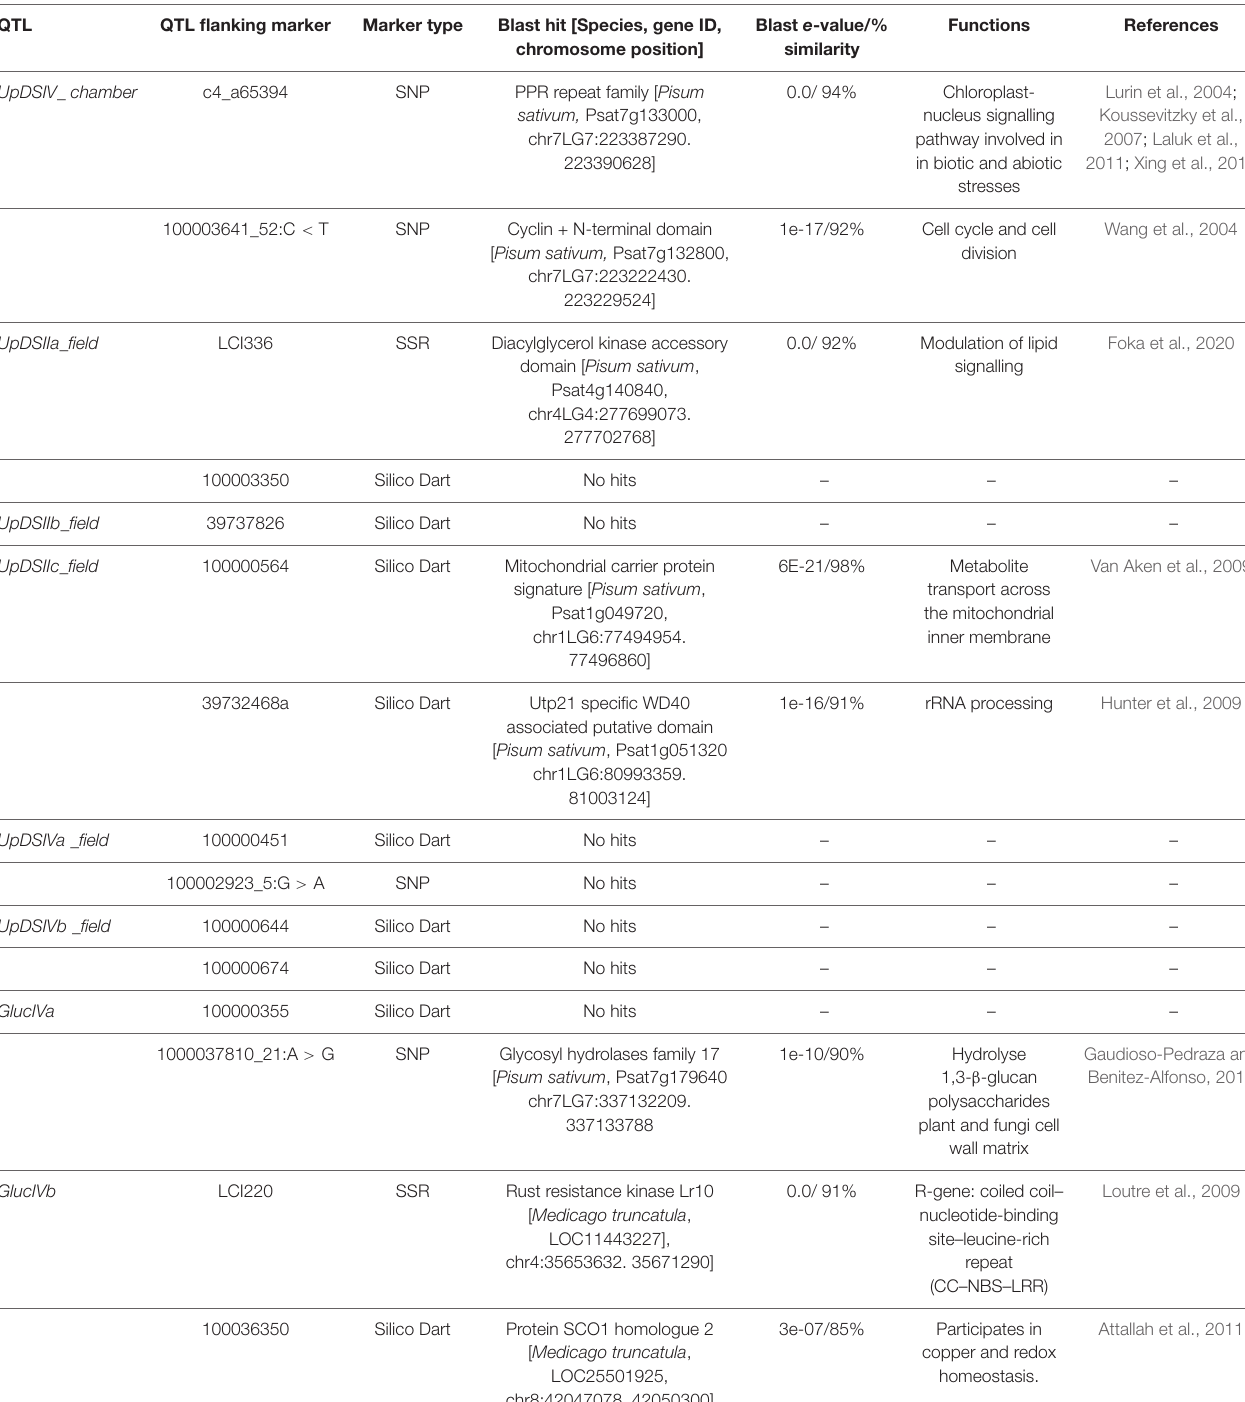
TABLE 4 | Phenotypic QTLs and expression QTLs’ flanking/peak markers and candidate genes identified for response to Uromyces pisi inoculation in the Lathyrus cicera RIL population (BGE023542 × BGE008277).